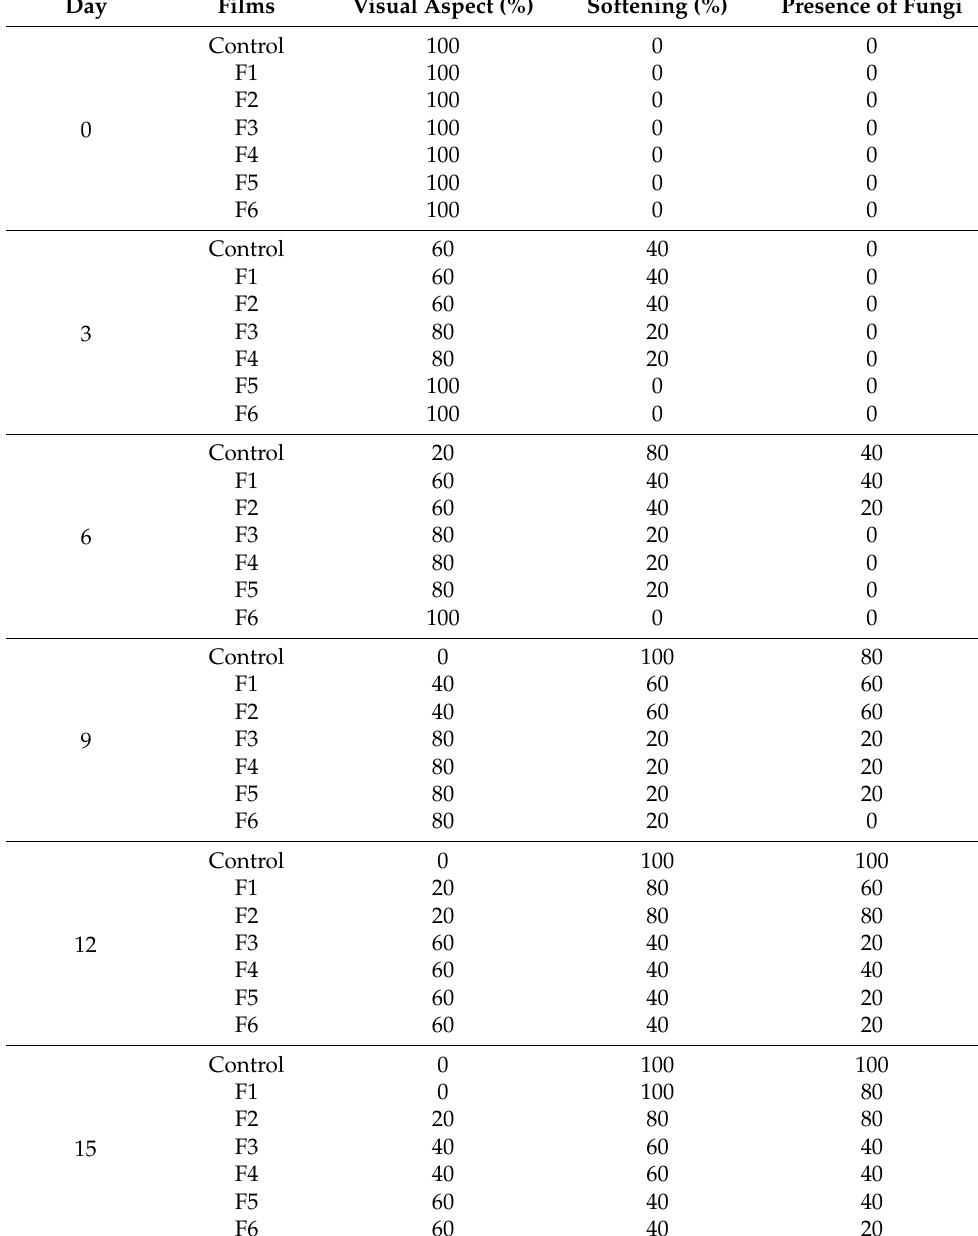
Table 6. Physical properties of baby carrots with and without coating (F1, F2, F3, F4, F5, and F6), stored under 85% RH at 25 ◦ C for two